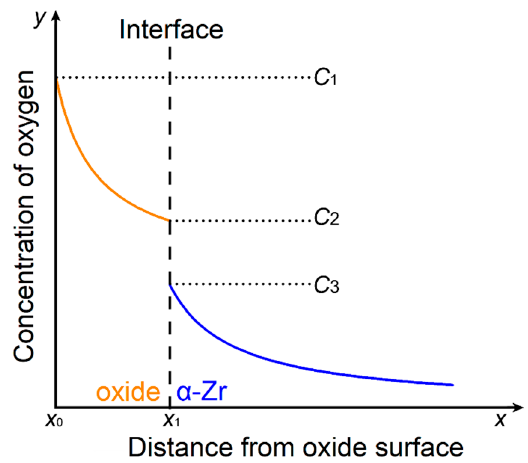
Figure 2. Schematic illustration of the oxygen concentration in the oxide film and the substrate by a suggested model (Reproduced form reference [39], with permission of Elsevier).